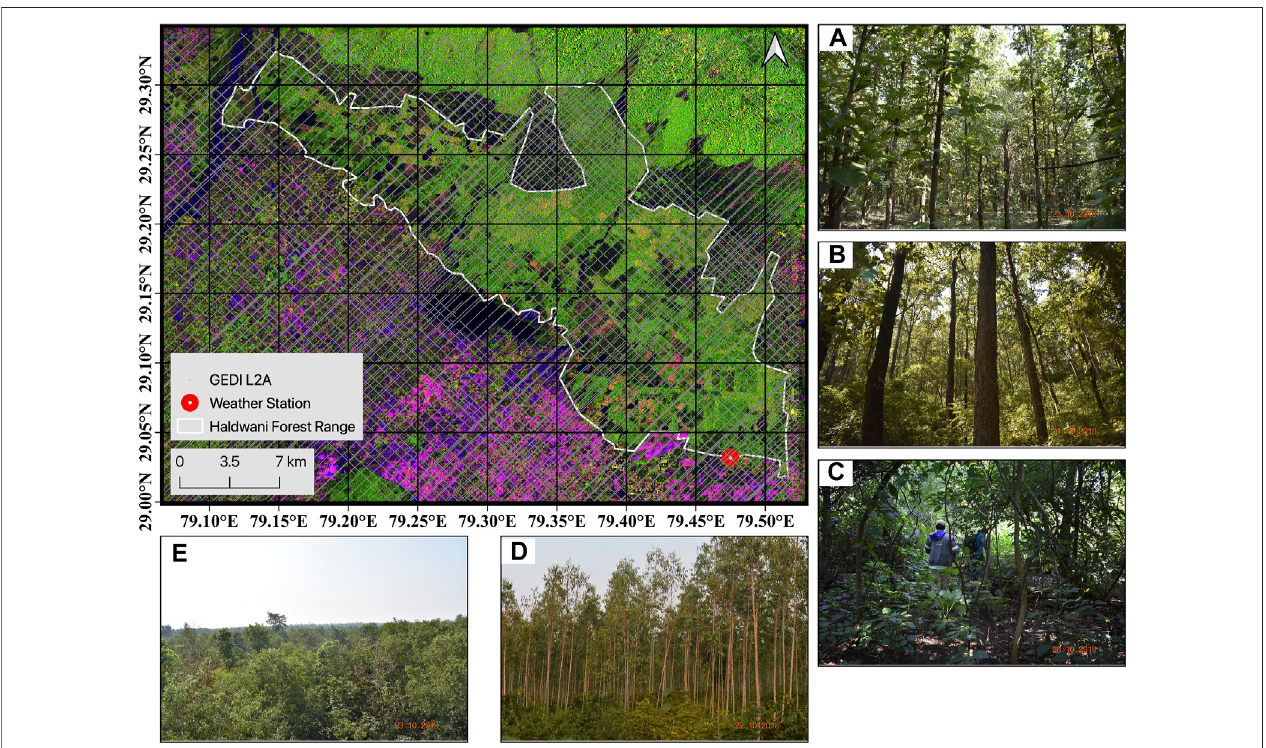
FIGURE 2 | Haldwani forest range imaged by ALOS-2/PALSAR-2 (R:G:B (cid:2) HH; HV; HH/HV). The location of the GEDI Level 2A observations over the test site is illustratedbythedensegraydots.The fi eldphotographsshow (A) teakplantation, (B) high-AGB teak-dominatedforest, (C) mixedforest, (D) Eucalyptus plantation,and (E) top of the canopy of the forest at a height of 25 m. All the fi eld photographs are from the fi eld campaign in October-November 2018.